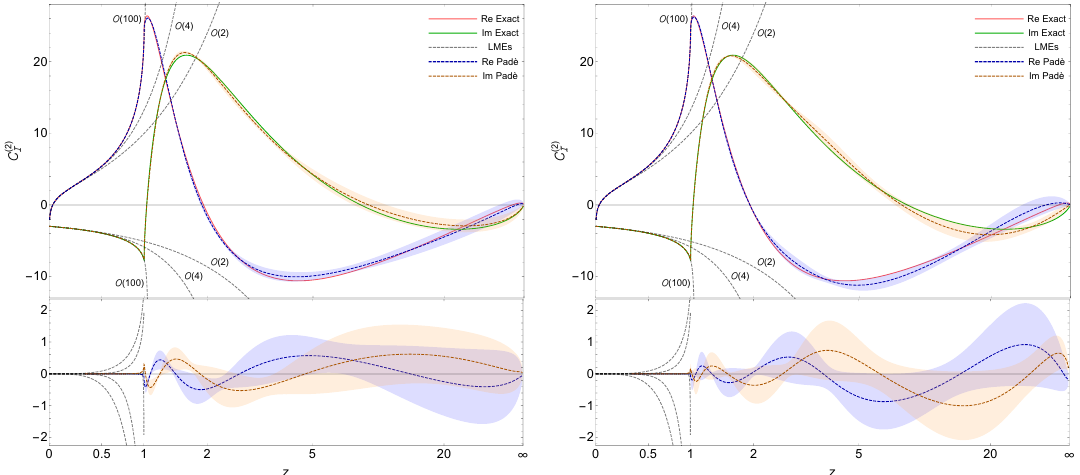
Figure 4 . Comparison of the three-loop coe(cid:14)cient of the (cid:12)nite remainder, eq. (2.9), at n l = 5, L (cid:22) = 0 ((cid:12)ve massless quarks, renormalisation scale (cid:22) 2 = (cid:0) s ), with the default Pad(cid:19)e approximation, [6 ; 1], constructed in ref. [9] (left panel) and improved to [7 ; 1] in ref. [26] (right panel), as function p of z = s= 4 M 2 with s the center-of-mass energy of the Higgs boson and M the mass of the single massive quark. The bands correspond to the uncertainty of the Pad(cid:19)e approximations as estimated in refs. [9] and [26]. The lower plot shows the absolute di(cid:11)erence between the approximation and the exact result. Also shown is the large-mass expansion (LME) of the three-loop coe(cid:14)cient of the (cid:0) (cid:1) (cid:0) (cid:1) (cid:0) (cid:1) (cid:12)nite remainder truncated at O z 2 ; O z 4 and O z 100